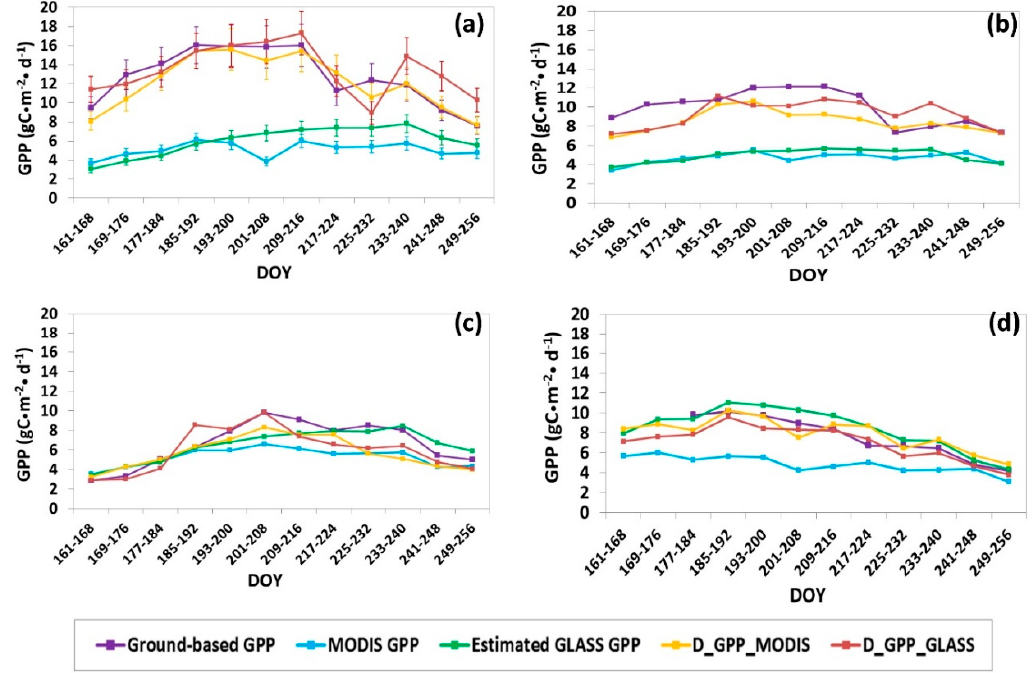
Figure 15. Comparison of ground-based GPP, MODIS GPP, estimated GLASS GPP, D_GPP_MODIS and D_GPP_GLASS: ( a ) Cropland; ( b ) orchard; ( c ) vegetable field; ( d ) wetland. Note that the GPP in cropland are the mean values of all sites in cropland.